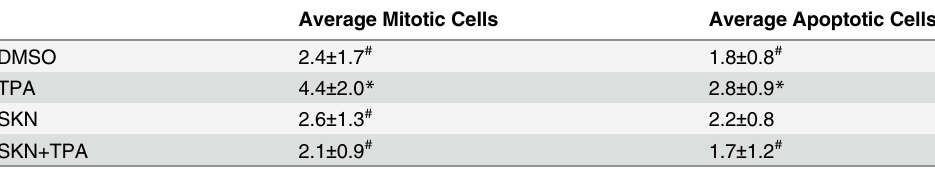
Table 2. Counts of mitotic and apoptotic cells in skin epidermal